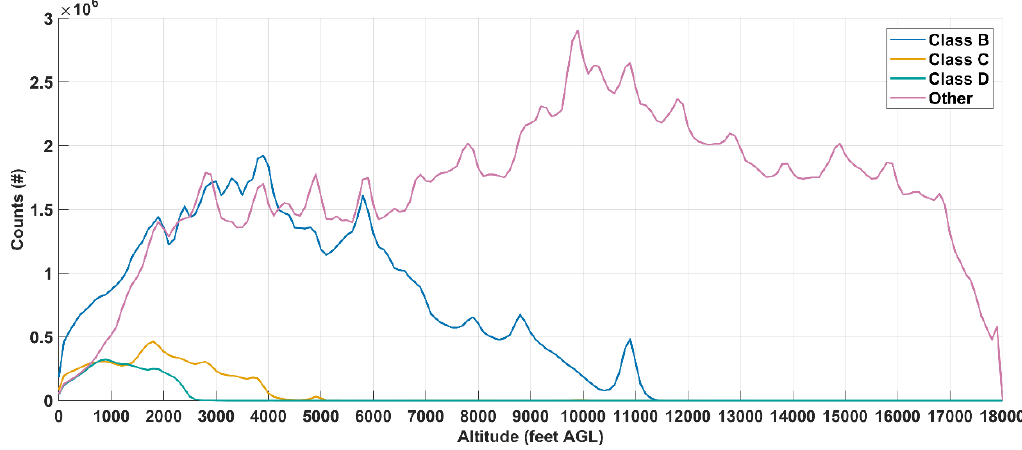
Figure 2. Altitude and airspace distributions for fixed wing multi-engine aircraft below 18,000 feet.